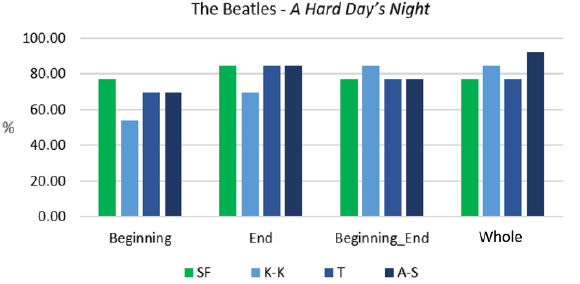
Figure 10. The key-finding efficacies obtained for the songs from the album A Hard Day’s Night by The Beatles; the analyzed samples represented with the multiplicities of occurrences of individual pitch-classes.